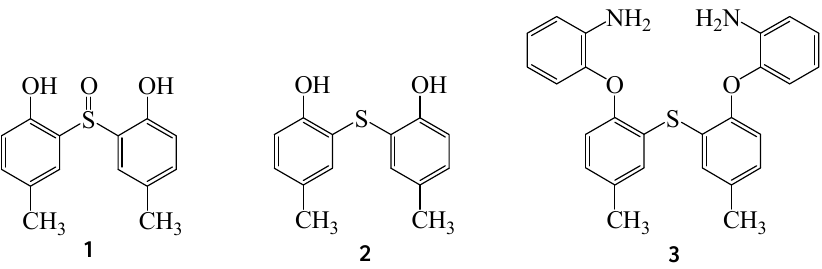
Figure 1. Examples of sulfoxides and diaryl sulfides.